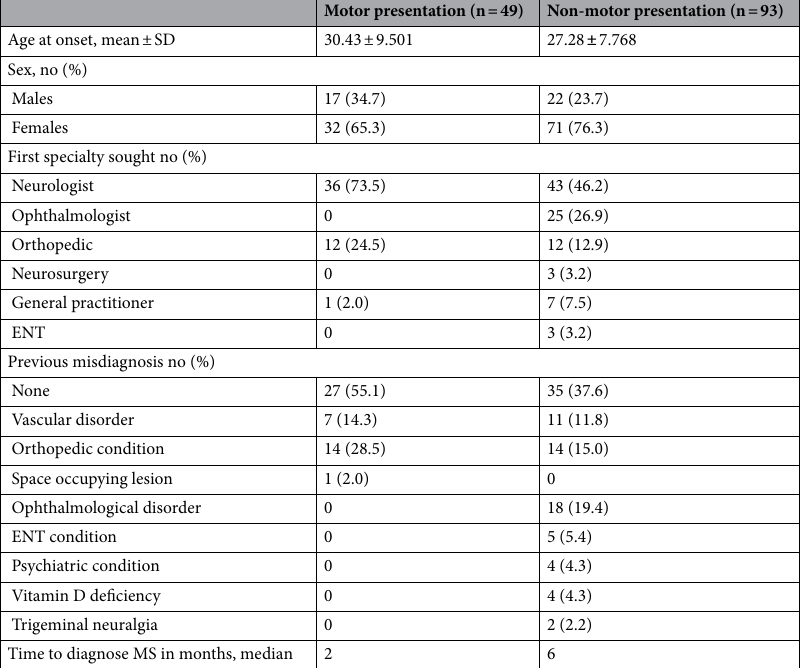
Table 2. Criteria of patients according to the initial presentation (motor Vs non-motor). SD, standard deviation.